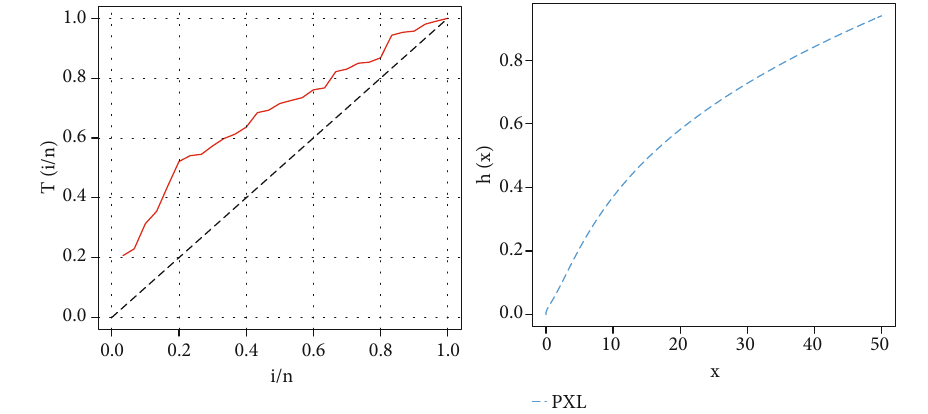
Figure 7: TTT plot and estimated HRF of PXL